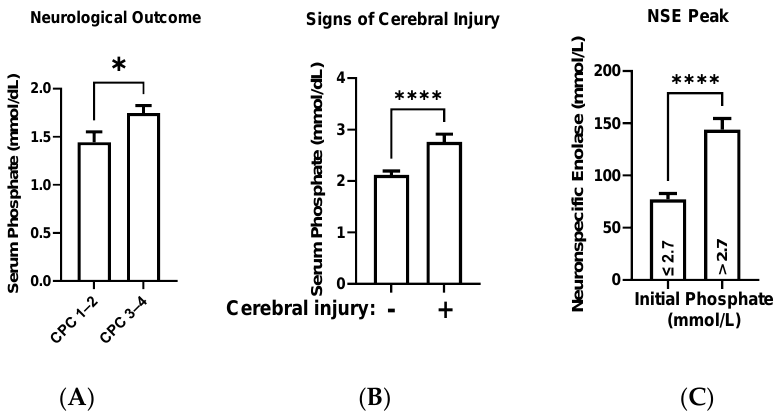
Figure 3. ( A ) Comparison of the average serum phosphate levels dependent on the neurological outcome measured by the cerebral performance index (mean phosphate: 1.4 ± 0.11 (SEM) in CPC 1 – 2 vs. 1.7 ± 0.08 mmol/L in CPC 3 – 4, Mann – Whitney test: * p = 0.0143). ( B ) Comparison of the av- erage serum phosphate levels in patients without and with morphological signs of brain injury,